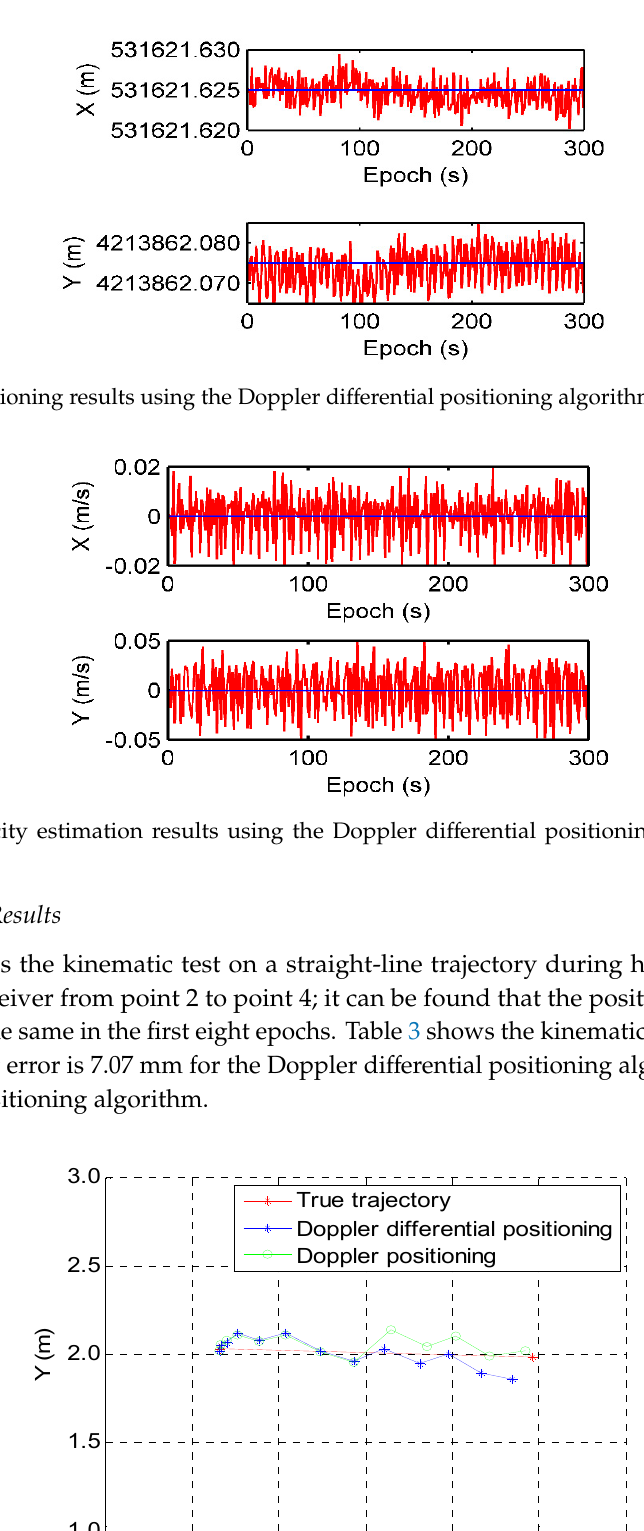
Figure 7. Kinematic test on a straight-line trajectory. Table 3. Kinematic positioning error on a straight-line trajectory.